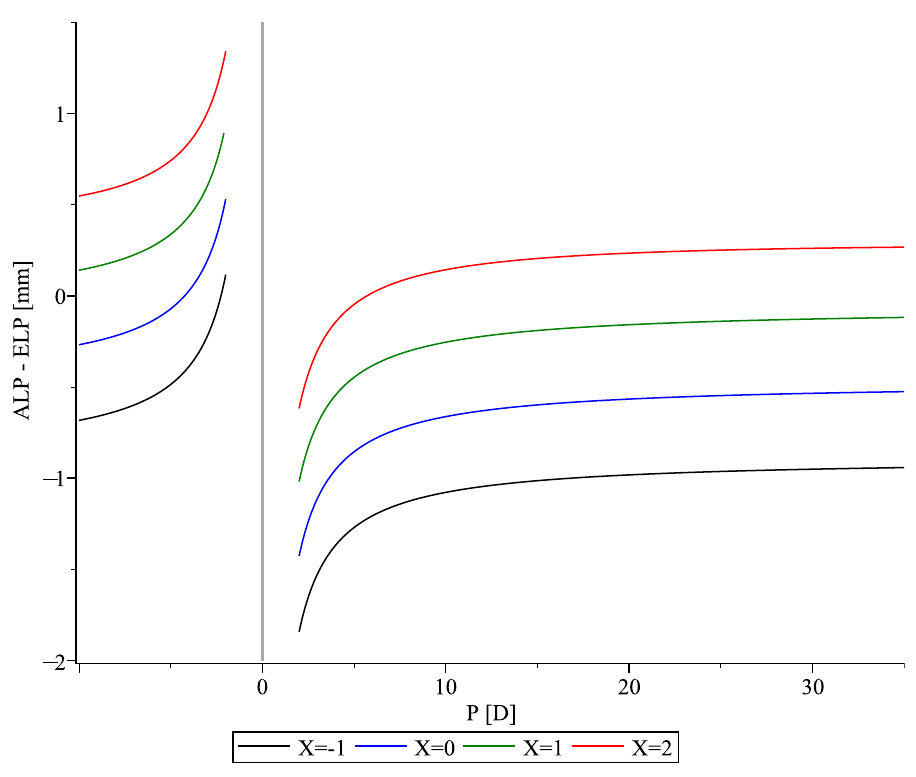
Fig 1. The difference between the anterior intraocular lens (IOL) vertex and the effective lens position of the thin lens equivalent as a function of IOL-power for IOLs with three different shape-factors X = -1, 0, 1, 2.